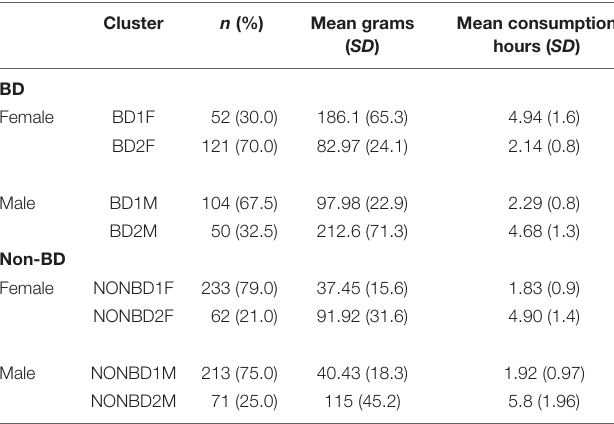
TABLE 2 | Binge drinking (BD) and non-binge drinking (non-BD) groups differentiated by sex resulting from the clusters analyses. Cluster